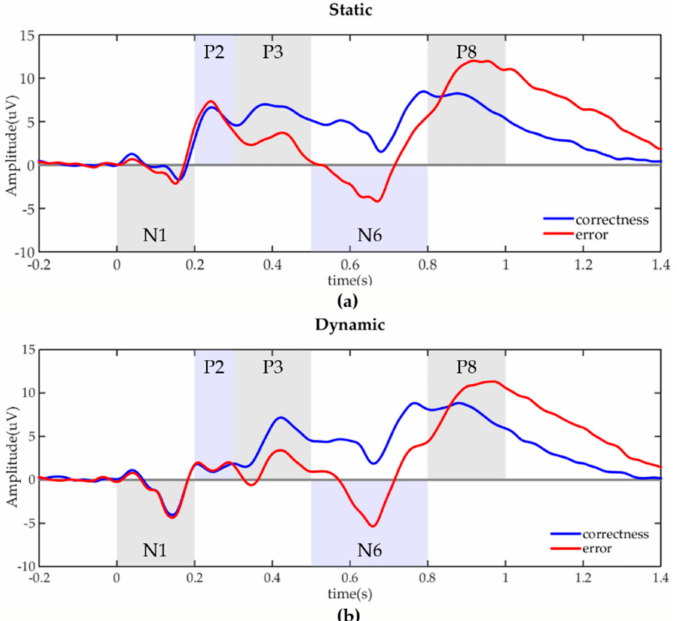
Figure 4. The grand average electroencephalogram (EEG) of all subjects at FCz channel. ( a ) Static visual stimulation; ( b ) Dynamic visual